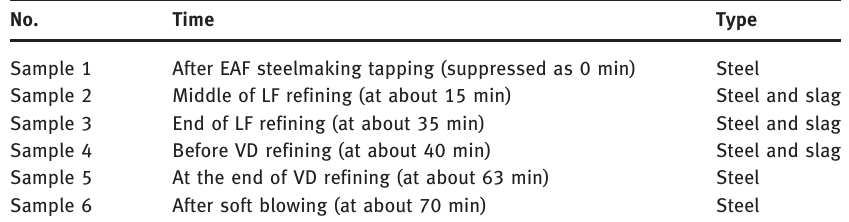
Table 2: Sampling steps of 95CrMo drill rod. No.